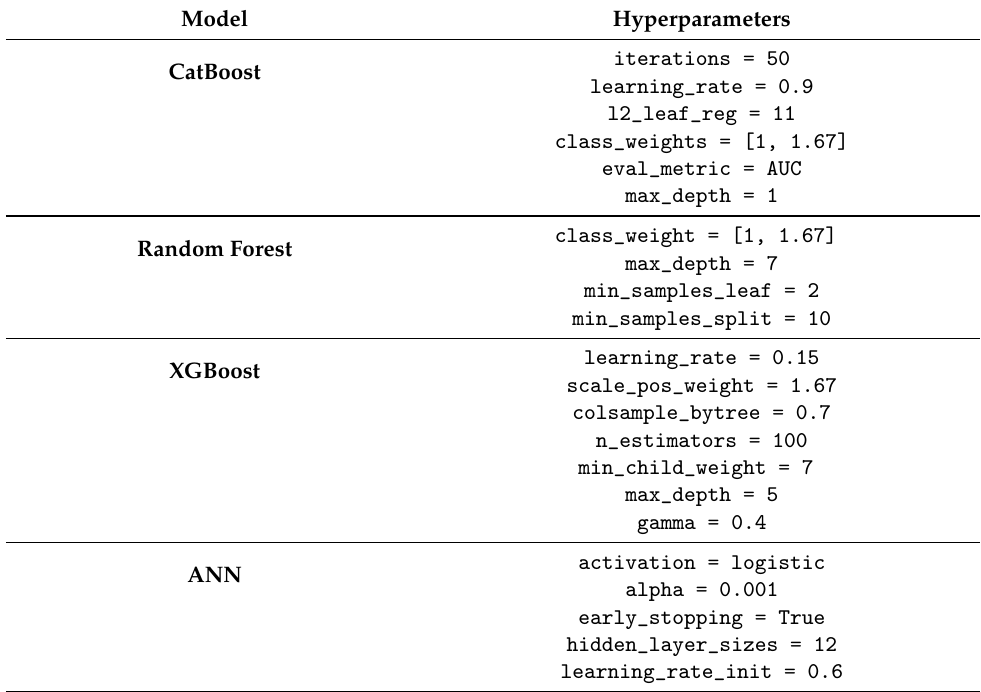
Table 3. Model’s